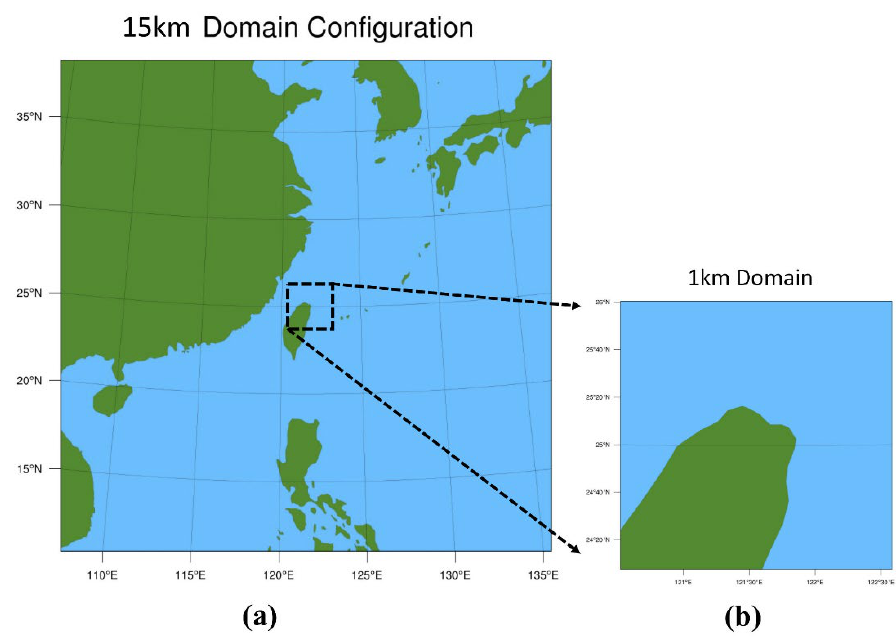
Figure 4. ( a ) Domain for WRF performance testing (resolution of 15 km). ( b ) Simulated domain of the test group (centered at Songshan Airport).